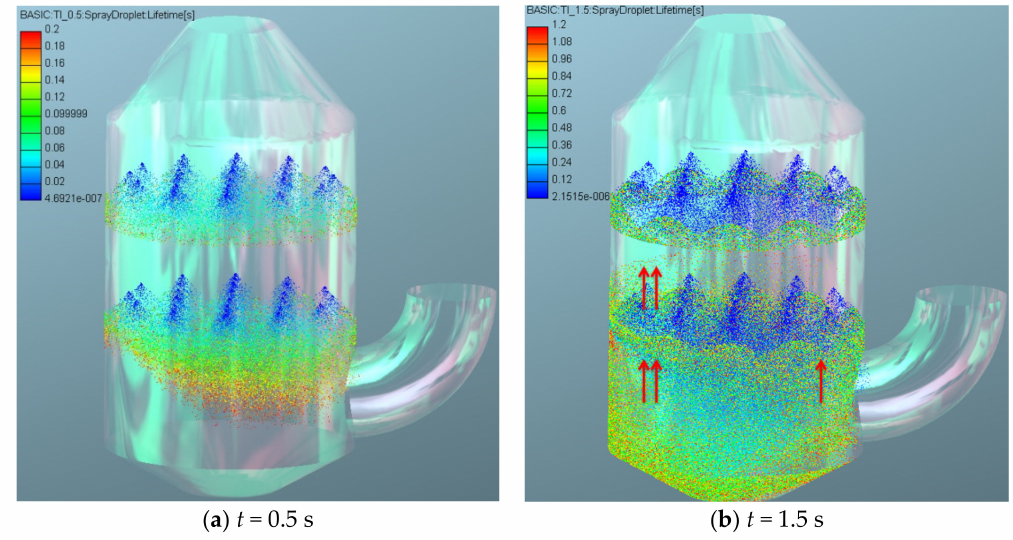
Figure 9. 3D distribution of the spray